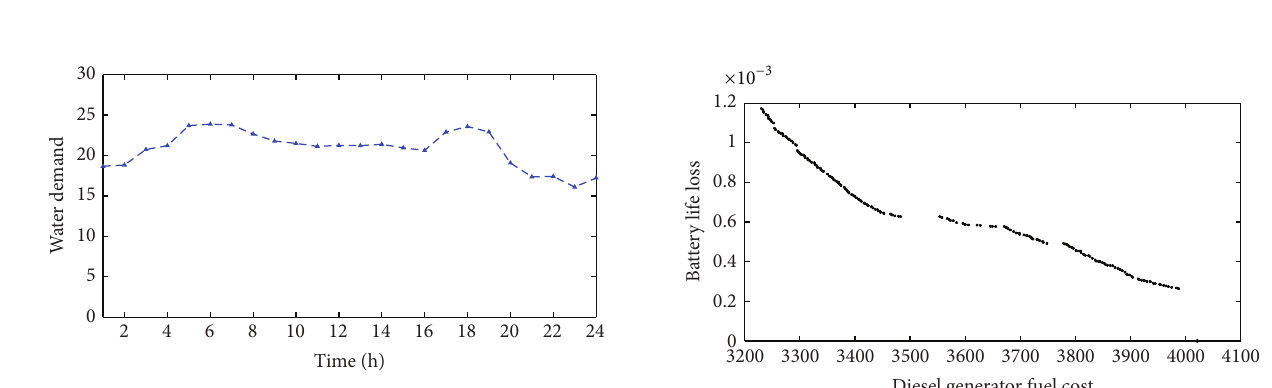
Figure 7: The conventional load in winter and summer.